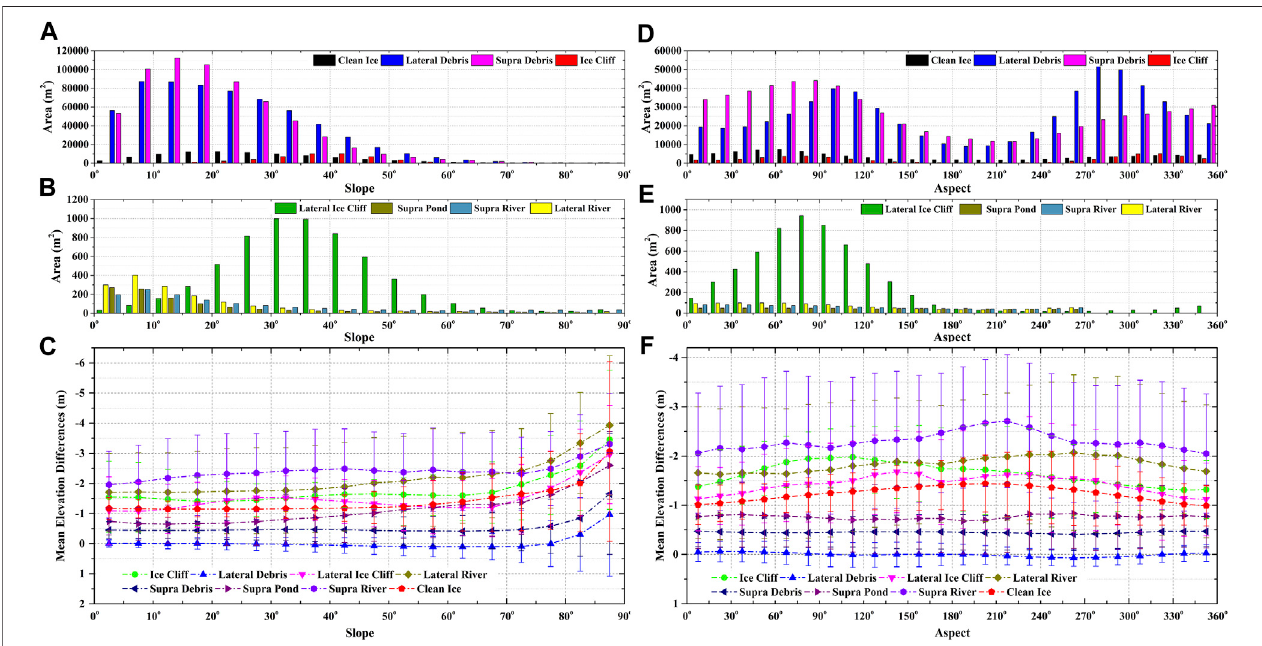
FIGURE 5 | The total area of different surface types within different slope (A) and (B) , in 5 ° interval) and aspect (D) and (E) , in 15 ° interval) ranges, and the relationships between elevation differences and surface slope (C) as well as aspect (F) within different surface types. The error bar represents the standard deviation of elevation differences in the surface type within different slope and aspect